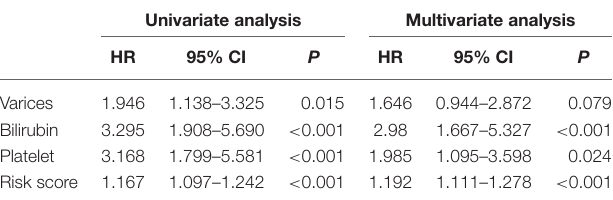
TABLE 3 | Univariate and multivariate Cox regression